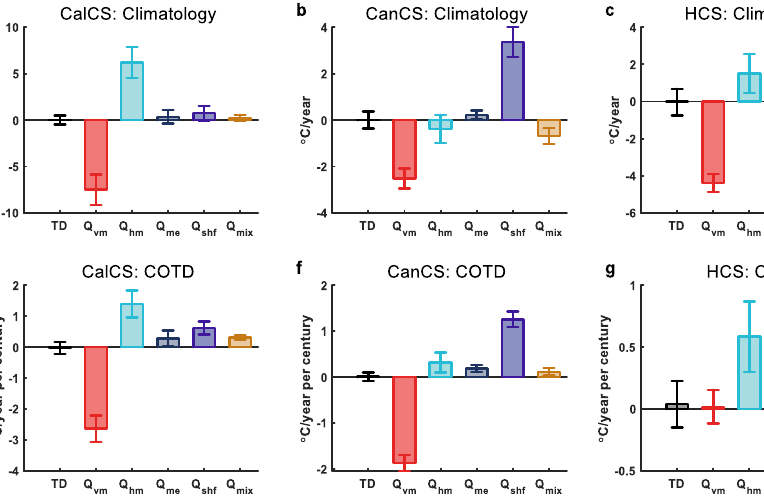
advection by mean fl ows, Q me the temperature fl ux convergence by mesoscale eddies, Q shf the contribution by the net sea surface heat fl ux and Q mix the para- meterized subgrid-scale mixing.Regionsusedforspatialaveragearedelineatedby the green boxes in Fig. 1a – h. The error bar denotes the 95% con fi dence level. e – h , Same as a – d , but for the coastal and oceanic trend difference (COTD) of individual heat budget terms during 2001 – 2100.